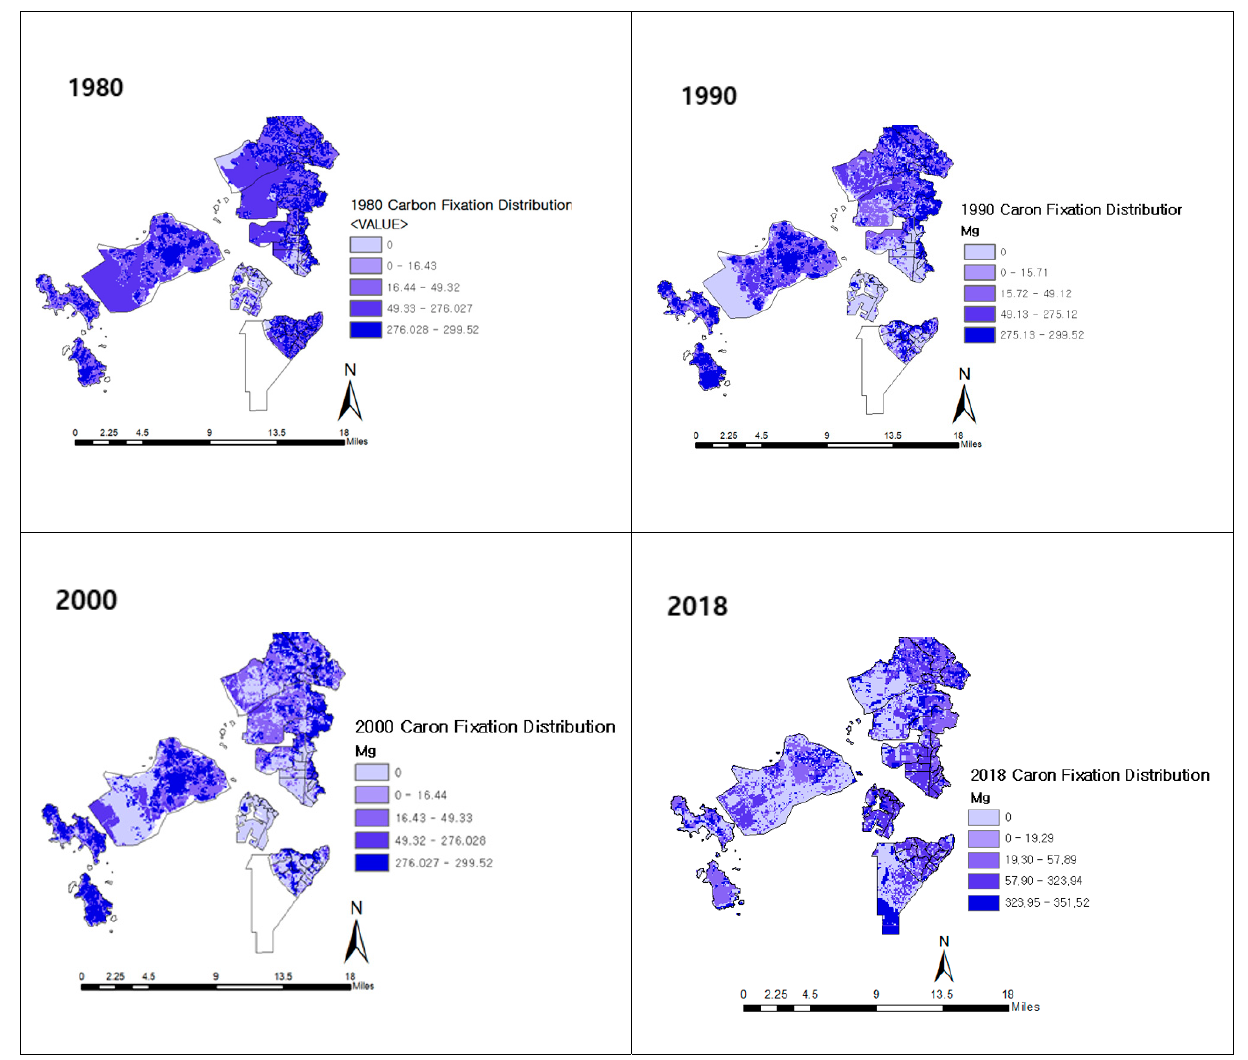
Figure 4. Carbon fixation from 1980 to 2018. The white areas (in the bottom right image) were not reclaimed until 2018. Table 6. Change in Carbon Fixation from 1980–2018.